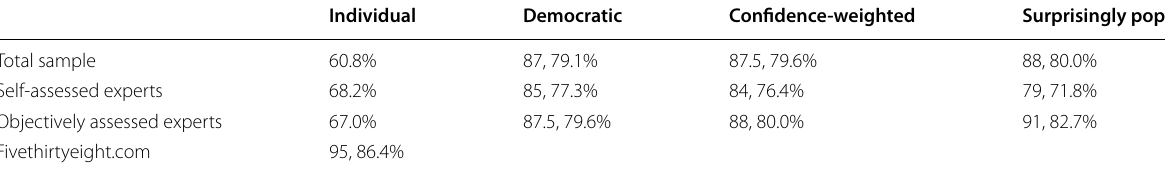
Table 2 Performance (correct predictions, % correct) across aggregation